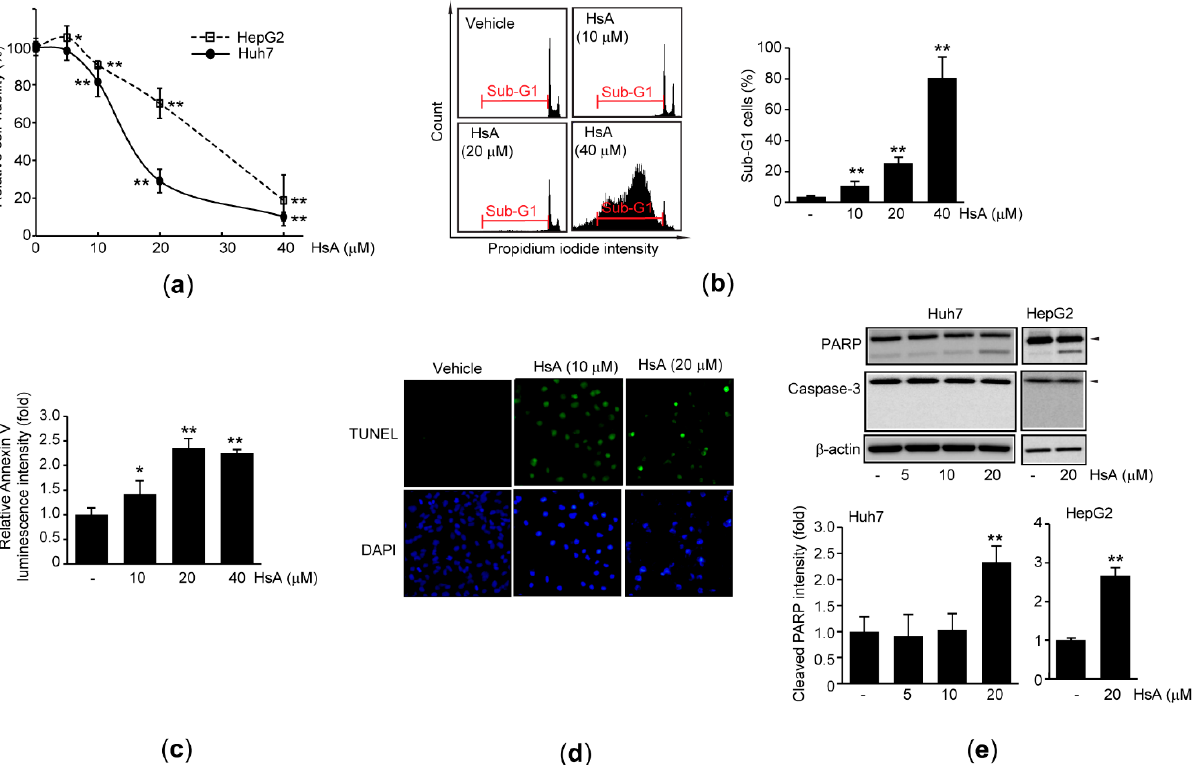
Figure 2. HsA activates the apoptosis of HCC cells. Huh7 (for a – e ) and HepG2 (for a and e ) were exposed to 5–40 µ M HsA for 24 (for b , d , and e ) or 48 h (for a , c ): ( a ) Relative cell viability of HsA-treated cells was determined by MTT assay; ( b ) Fluorescence intensity of PI-stained cells was monitored using a flow cytometer (left), Sub-G1 cells were expressed as a percentage of the total cell analyzed (right); ( c ) Annexin V binding activity was determined using a luminometer; ( d ) Fragmented DNAs were stained by TUNEL, and nuclei were counter-stained by DAPI; ( e ) Changes of PARP and caspase-3 expression were determined by immunoblotting. Equal protein loading was verified by β -actin immunoblotting. Arrowheads in immunoblot images indicate precursor forms of PARP and caspase-3 (upper). Band intensity of cleaved PARP was quantified by scanning densitometry (lower). ** p < 0.01, * p < 0.05, significance versus vehicle-treated cells.